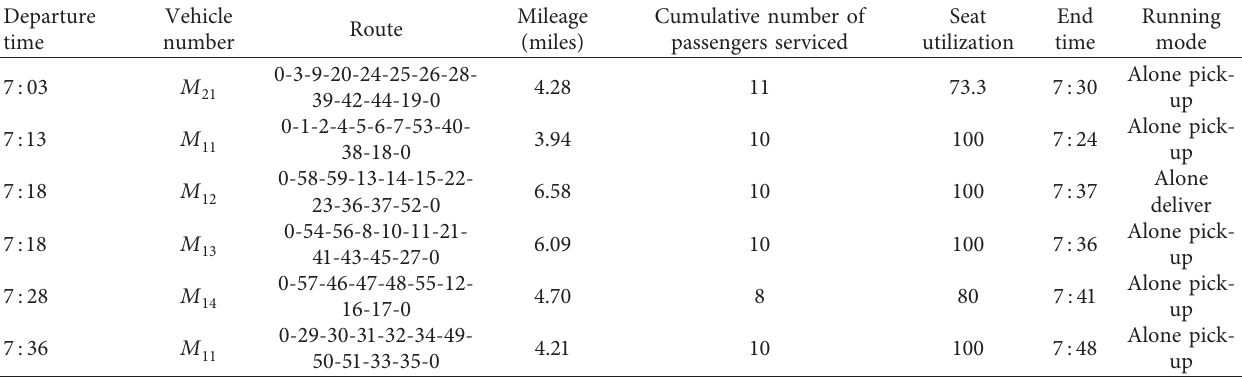
Table 8: Optimization results under pick-up and deliver alone in the initial service area.